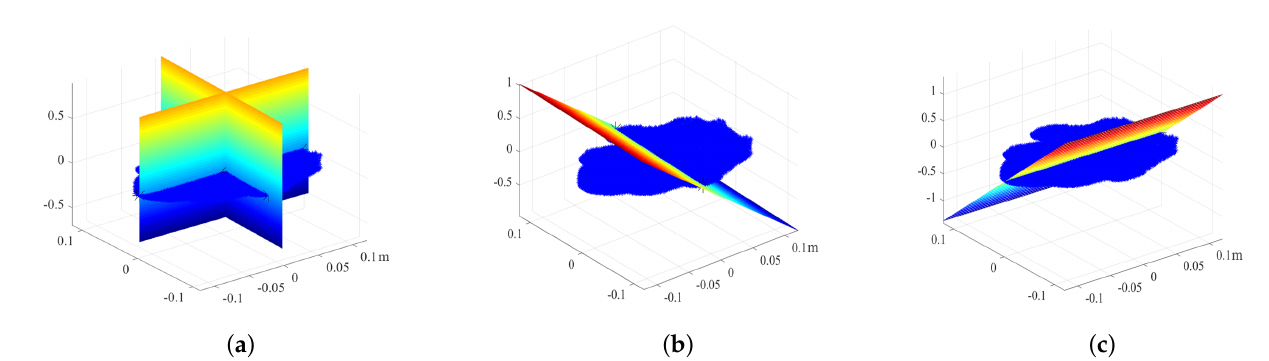
Figure 5. Obtaining spatial length and width planes of leaf. ( a ) Spatial planes of length and width by cross-section method. ( b ) Spatial plane of width according to this paper. ( c ) Spatial plane of length according to this paper. The length and width cut planes obtained by this paper are not perpendicular to the coordinate plane. The essence of our method is to use the tangent plane to cut the model and obtain the point on the intersection line as the basis for calculating the length and width. The leaf model intersects with the length and width planes, which are used to measure the distance of length and width in Algorithm 2. Algorithm 2 The algorithm of calculating leaf length and width. Process of calculating leaf